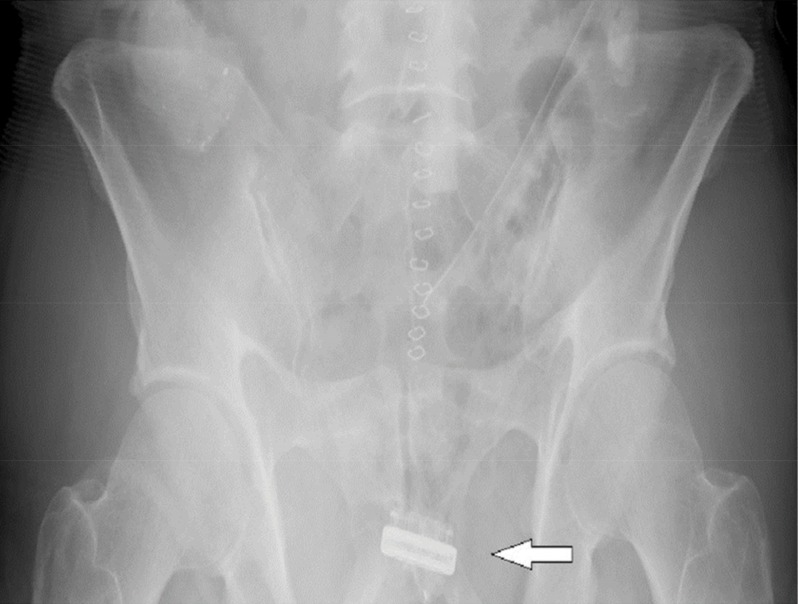
Abdominal radiographs showing the preliminary healing of anastomotic leakage after 5 days post-operation with the ring (arrow) retained in the anastomosis before the ileostomy takedown.